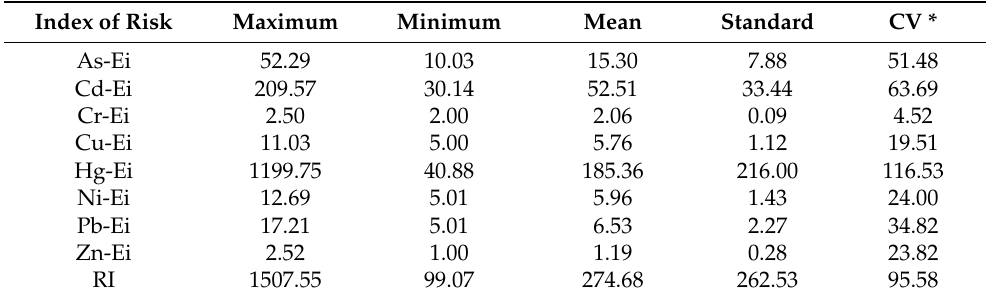
Figure 6. Distribution of RI index of coking plants causing potential ecological risk to the surrounding soil for each single PHE. Table 3. Descriptive Statistics of Cumulative Ei and RI of Coking Plants in BTH (N = 80). Index of Risk Maximum Minimum Mean